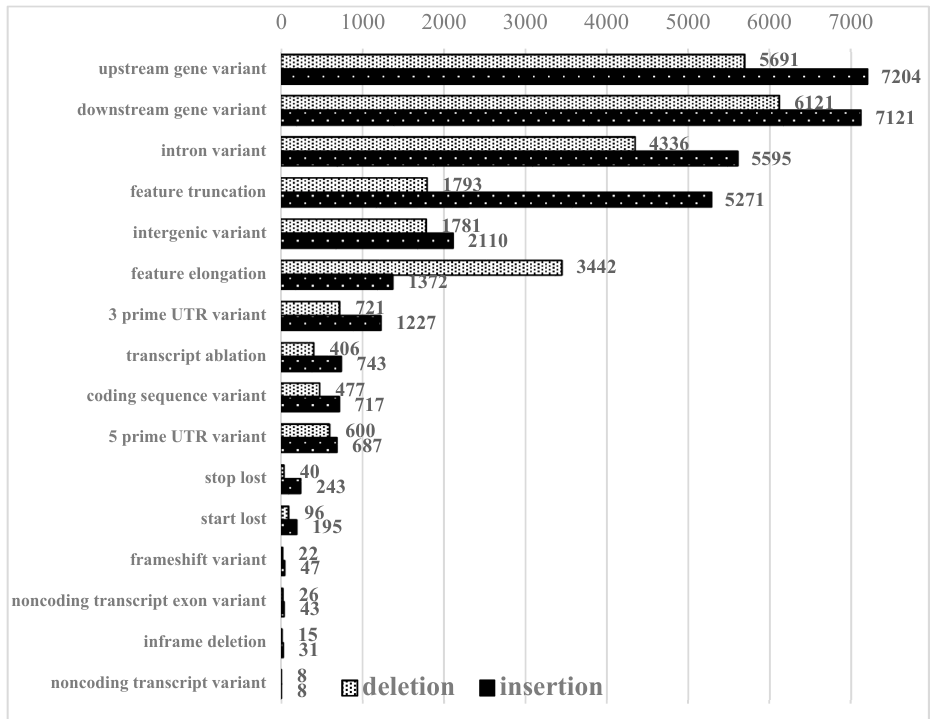
Figure 1. Predicted consequences of identified structural variants.